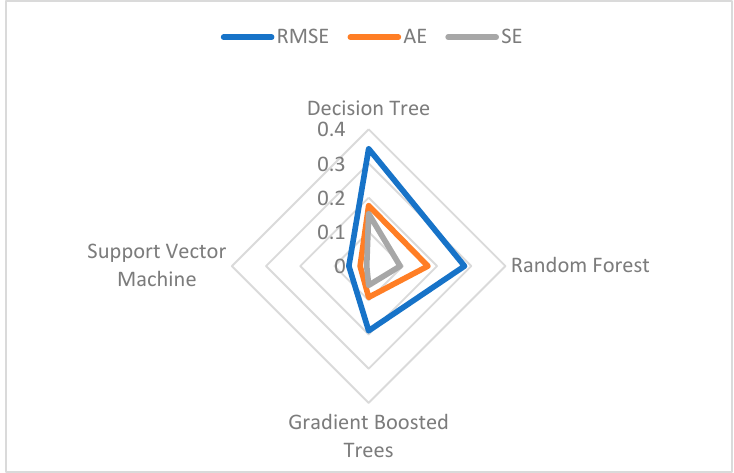
Figure 8. Comparison of the applied learners.